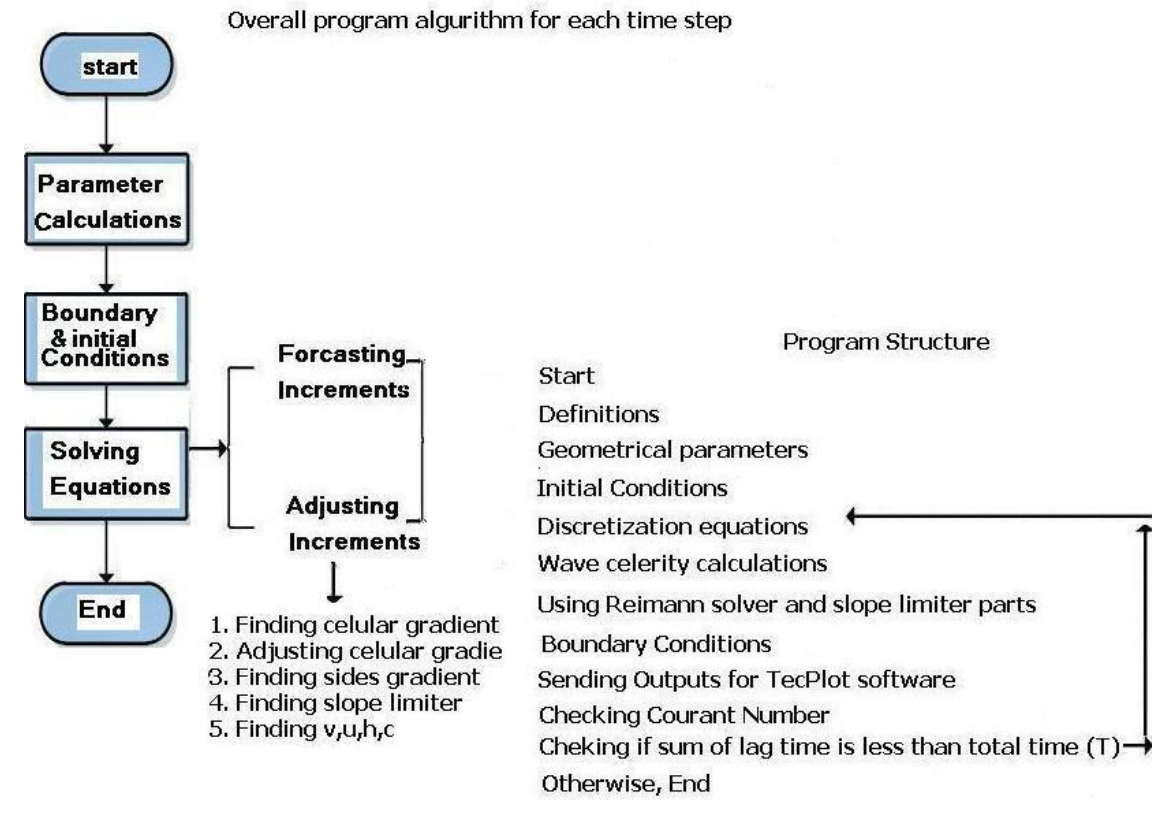
Fig. 1 Building block of Code structure for each